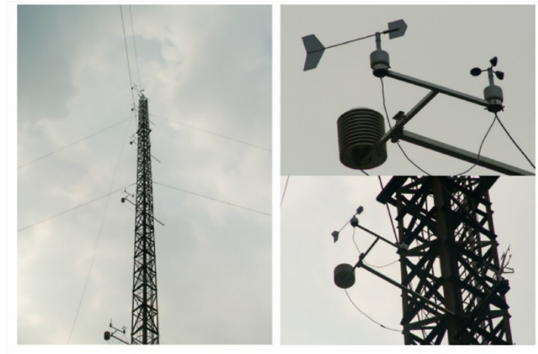
Figure 4. Meteorological tower at Nanjing University.